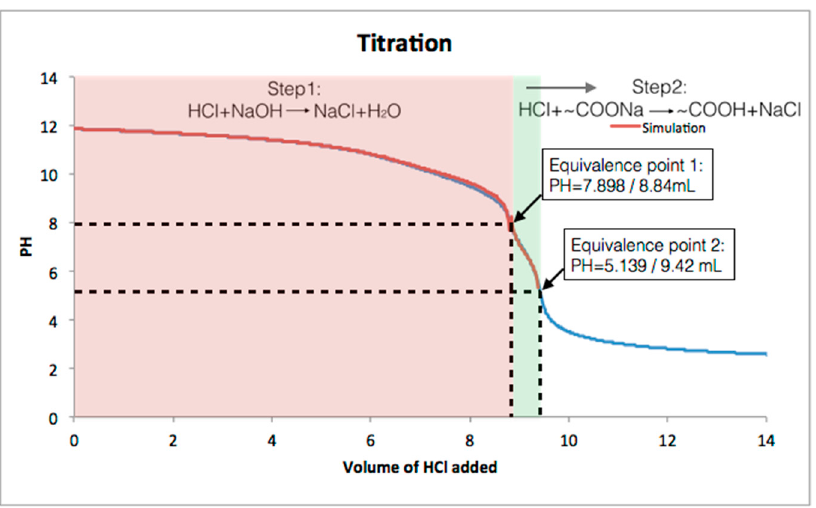
Figure 3. Titration curves for suspensions of COF 5 . Red curve is the simulation and blue curve is the data.